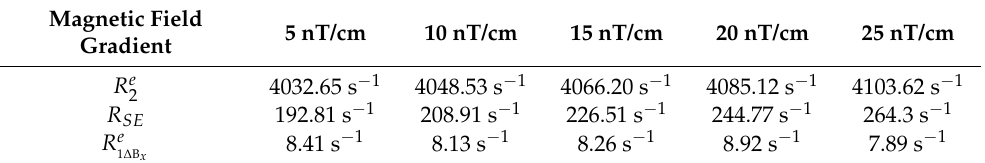
Table 2. Experimental results of magnetic gradient relaxation of alkali metal atoms in coupled spin ensemble under applied x -axis magnetic gradient.